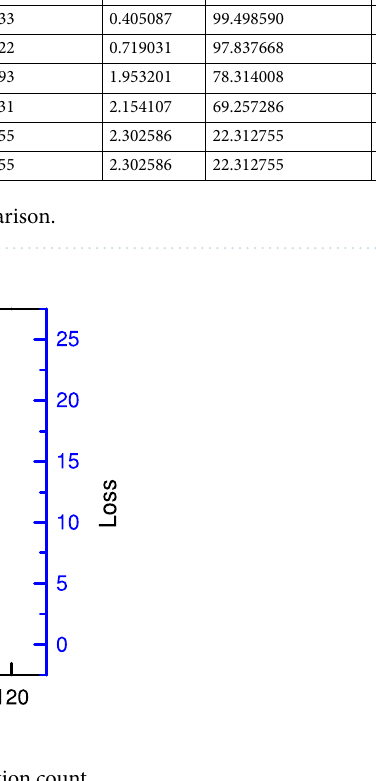
Figure 22. R-square and loss in terms of removed connection